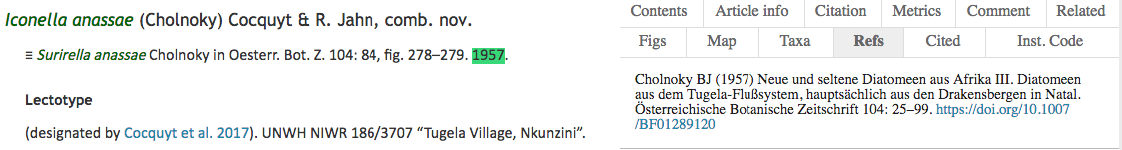
Fig. 3. Contrary to the example in Fig. 2, and despite it being published in the same journal, here “Cholnoky 1957” is cited only in the taxonomic treatment (and nowhere else in the text) and referenced under the bibliographic section (Jahn et al.